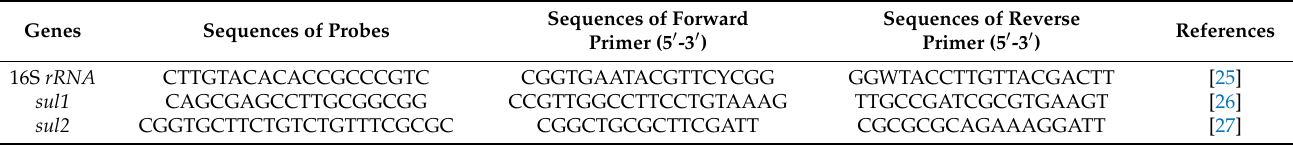
Table 1. Probes and primers used for the real-time qPCR. Genes Sequences of